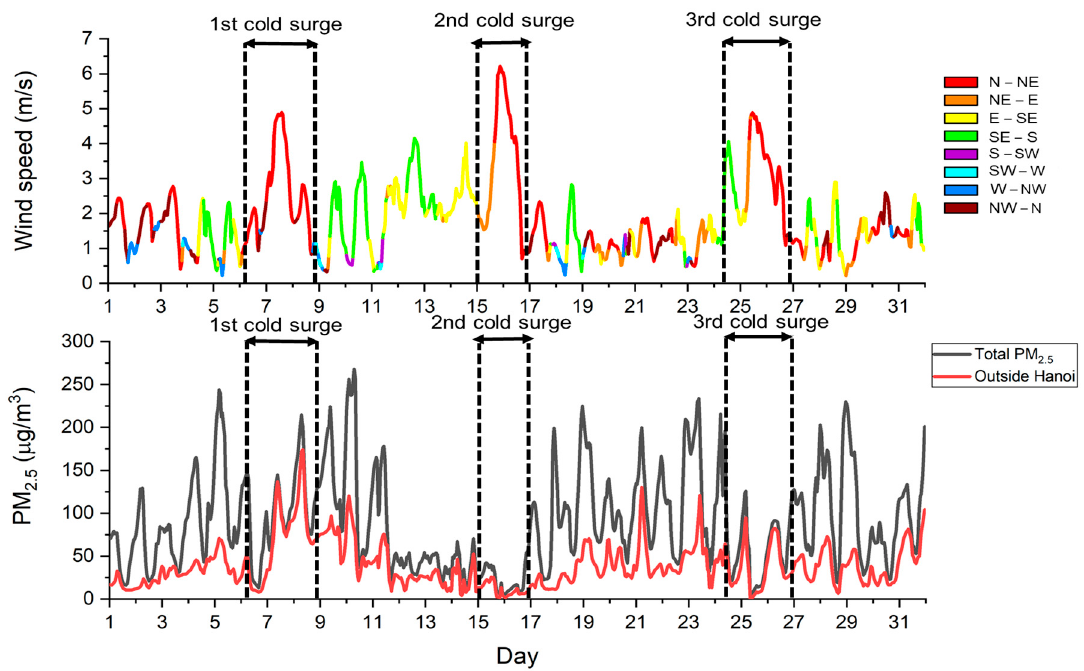
Figure 10. Temporal variations in the simulated hourly mean WS and WD ( Top ) and PM 2.5 concentrations determined in standard and sensitivity runs ( Bottom ) at two air quality stations. The black and the red lines show values from the standard and sensitivity runs, respectively. Total PM 2.5 is depicted by the black line while the PM 2.5 from non-local emission sources is shown by the red line. The dashed columns show the periods when transported PM 2.5 was dominant.